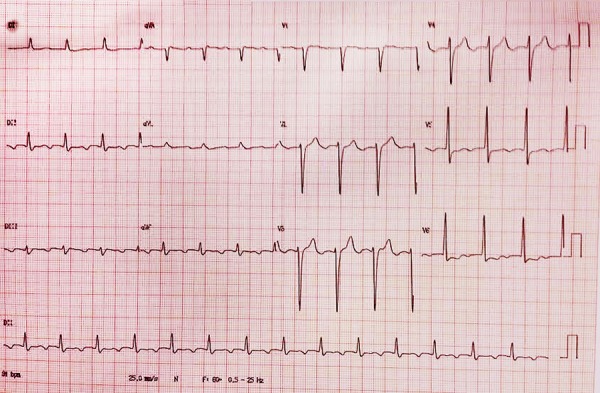
Electrocardiogram.